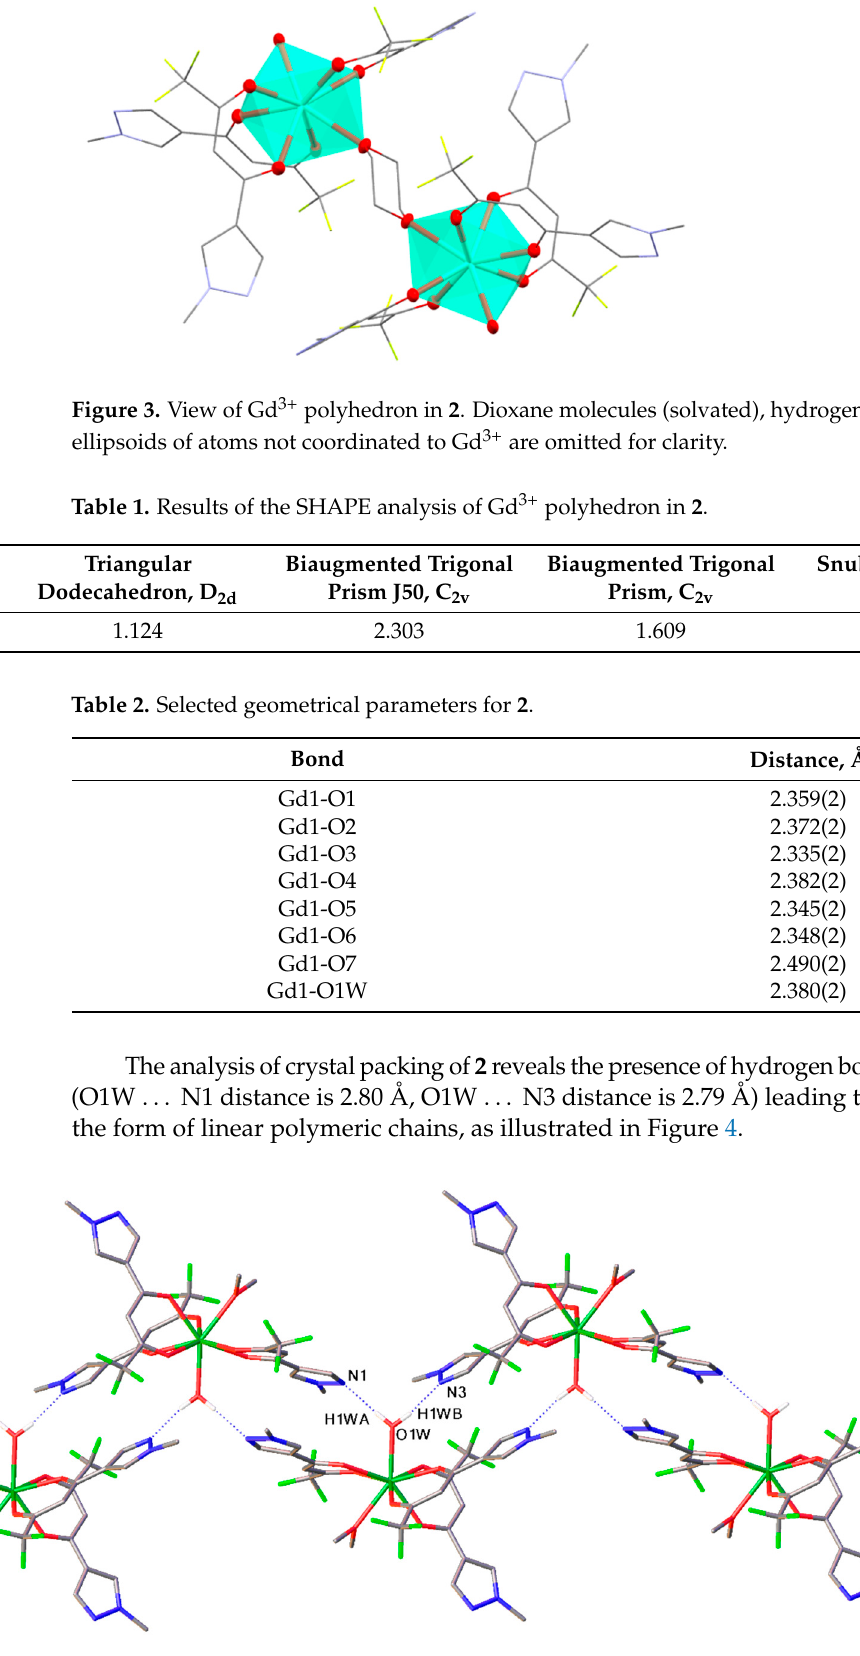
Figure 4 . Fragment of crystal packing of 2 . Hydrogen O-H…N bonds are presented as dotted lines. Figure 4. Fragment of crystal packing of 2 . Hydrogen O-H . . . N bonds are presented as dotted